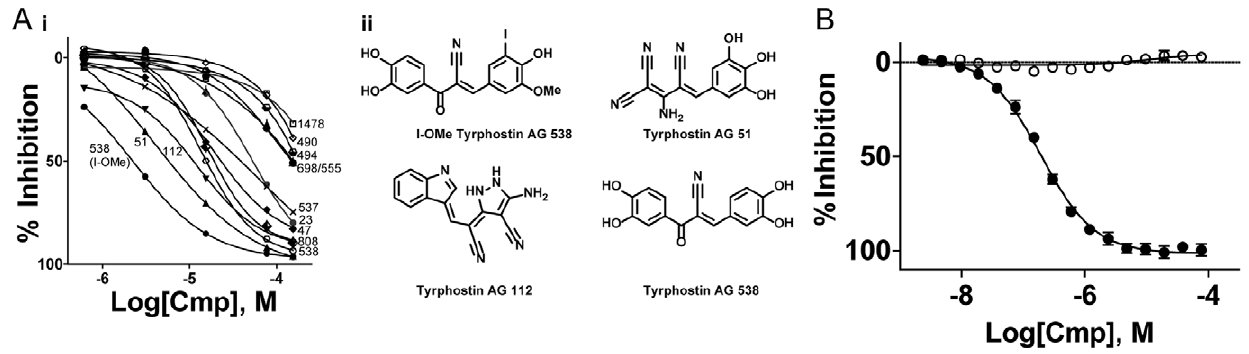
Figure 5. Confirmation of inhibitors. (A) i , The IC 50 inhibition curves of the tyrphostin analogues identified from the Lopac library are shown. Numbers refer to the tyrphostin analog and IC 50 s were determined to be as follows: tyrphostin I-OMe-AG-538 (2 m M), tyrphostin 51 (5 m M), tyrphostin AG 112 (13 m M), tyrphostin AG 538 (14 m M), tyrphostin AG 808 (18 m M), tyrphostin 47 (20 m M), tyrphostin AG 537 (32 m M), tyrphostin 23 (45 m M), tyrphostin AG 555 (50 m M), tyrphostin AG 698 (50 m M), tyrphostin AG 490 (89 m M), tyrphostin AG 494 (89 m M), tyrphostin AG 1478 (100 m M). ii , Structures of the four most potent tyrphostin analogs. (B) The IC 50 curves with standard deviation error bars (N=2) of tyrphostin I-OMe-AG-538 in the PI5P4K a assay (squares) and the counterscreen (open circles).